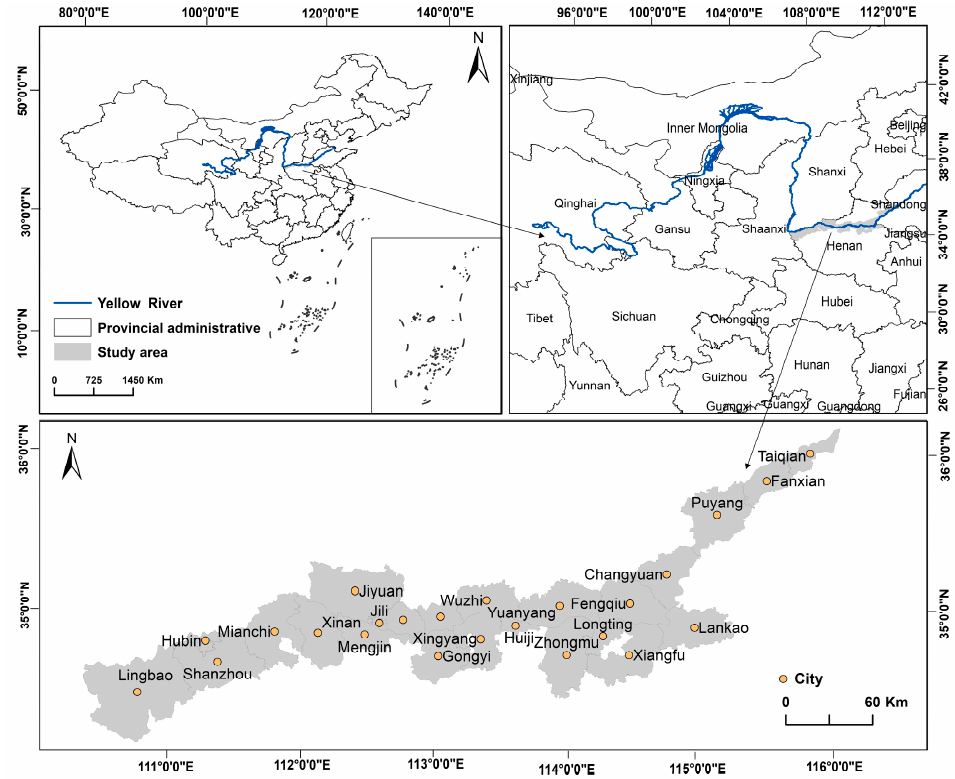
Figure 2. Study on the zoning map.